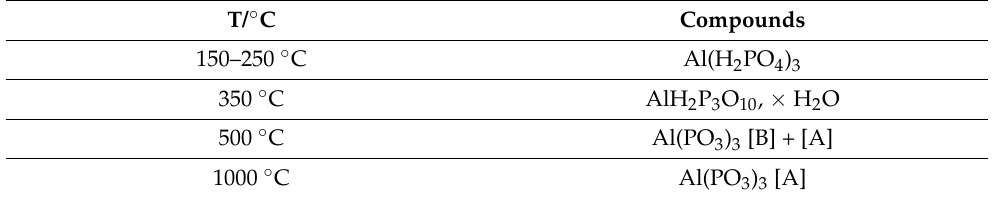
Table 1. The chemical structure and temperature domains of compounds involved in the thermal evolution of P/Al = 3 solution (from